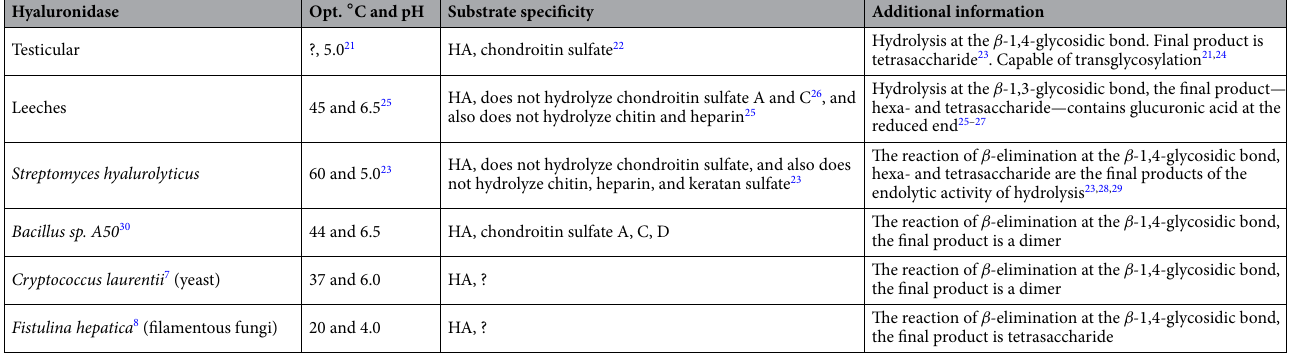
Table 1. Some known